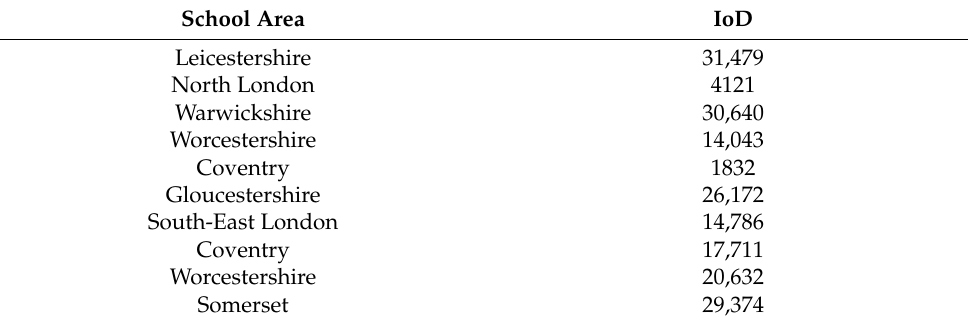
Table A1. School Area and English Indices